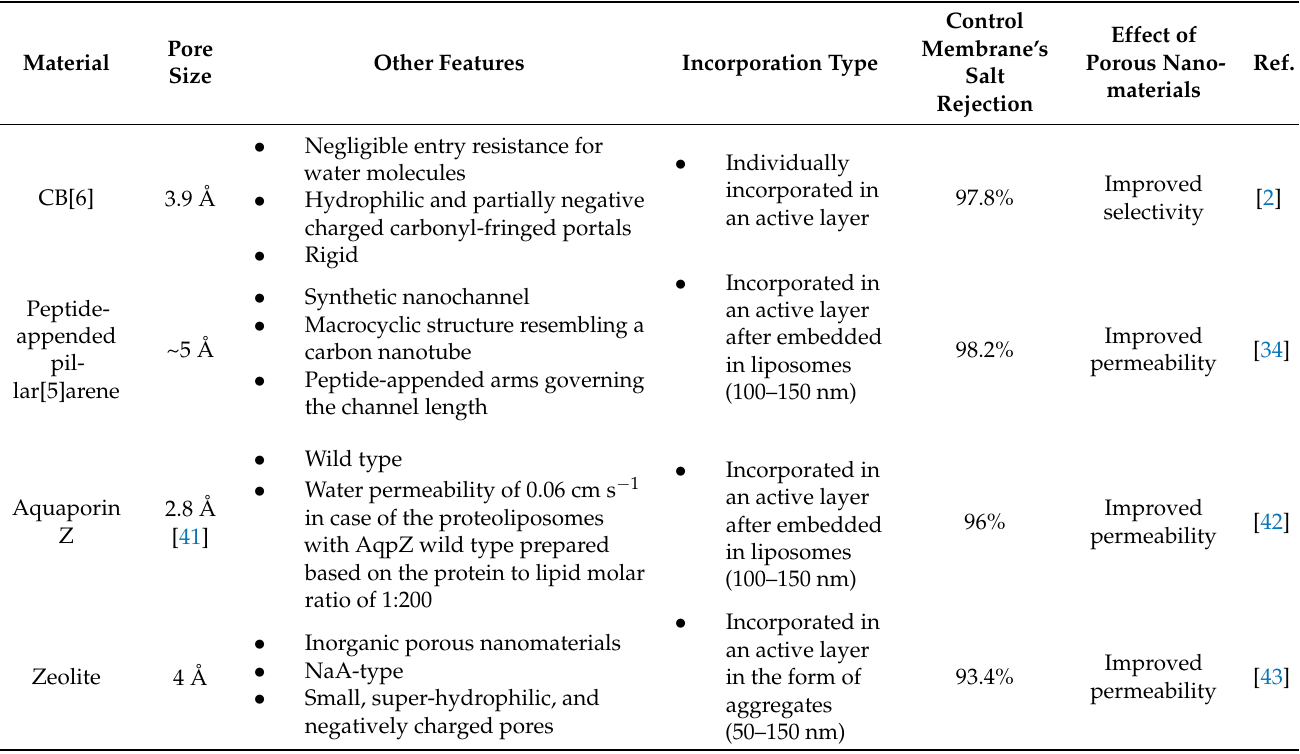
Table 1. Potential porous nanomaterials to prepare highly selective RO